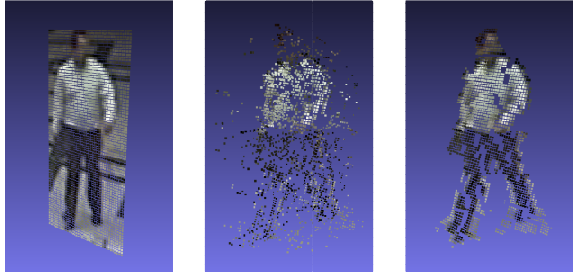
Figure 2. Planar prior (left), result of WTA (centre) and result of the proposed approach (right).